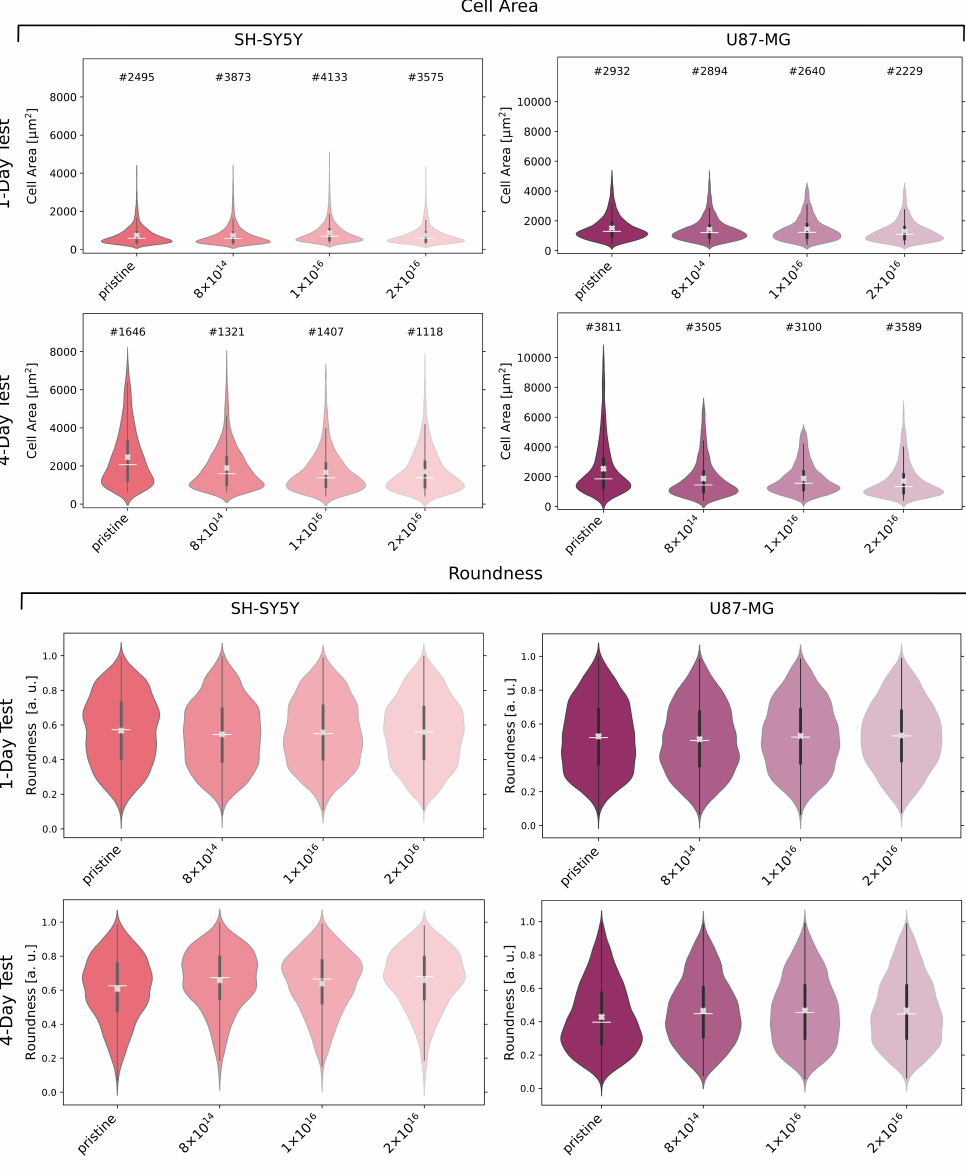
Figure 4. Cell area and cell roundness of U87-MG and differentiated SH-SY5Y cells after incubation of one and four days(s), respectively, on examined TNSs. Analyzed cell count (#), mean (white line), median (white cross), and interquartile range (dark gray) of the data distribution of detected cells. Ion fluences are given in ions · cm − 2 . The roundness of U87-MG, as well as of SH-SY5Y cells after one day, appears to be independent of C implantation, as the median cell roundness does not significantly differ for all TNSs. After four days, the roundness of the U87-MG cells decreases on all TNSs, i.e., cells are more elongated. However, cells on the TNSs implanted with 2 × 10 16 ions · cm − 2 are 12% more round than cells on the pristine